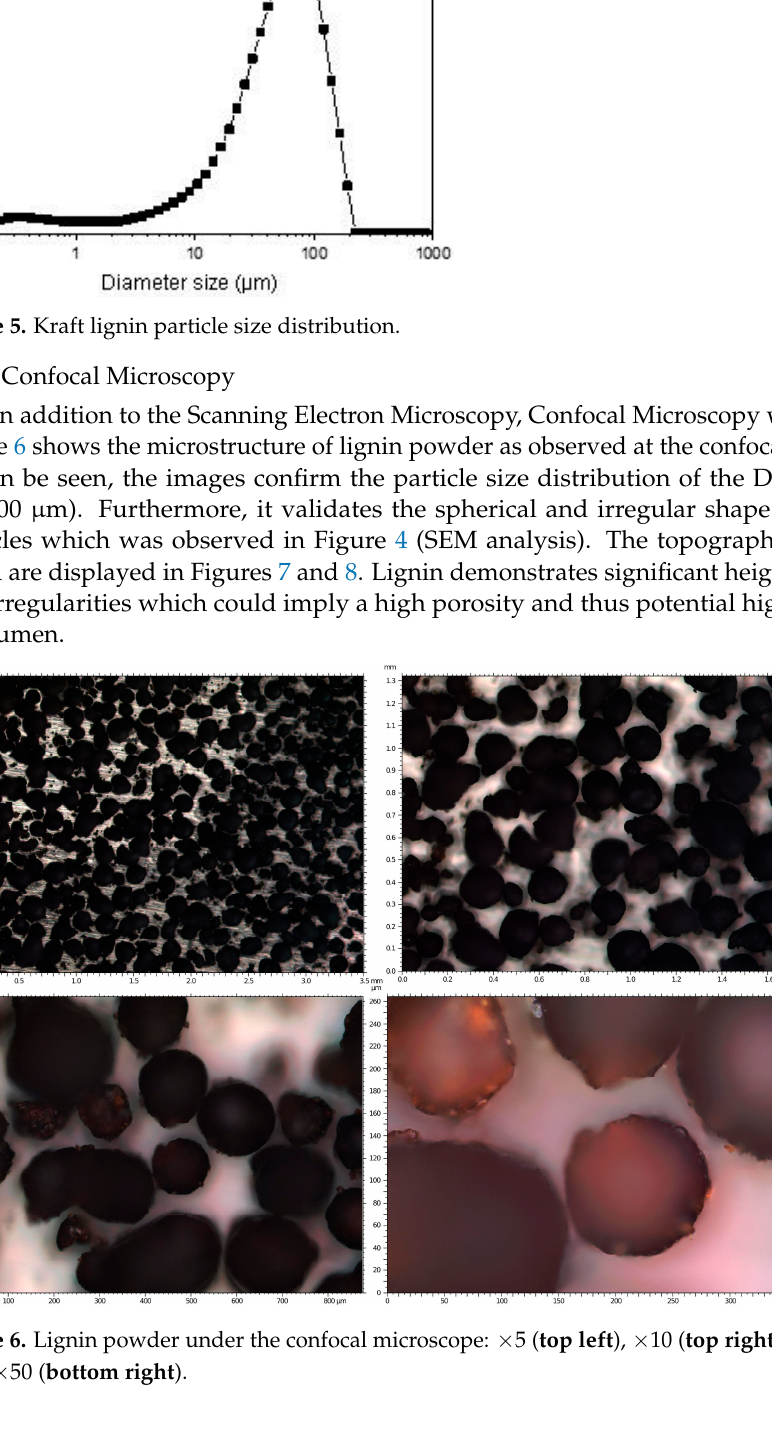
Figure 4. Lignin particles under SEM .